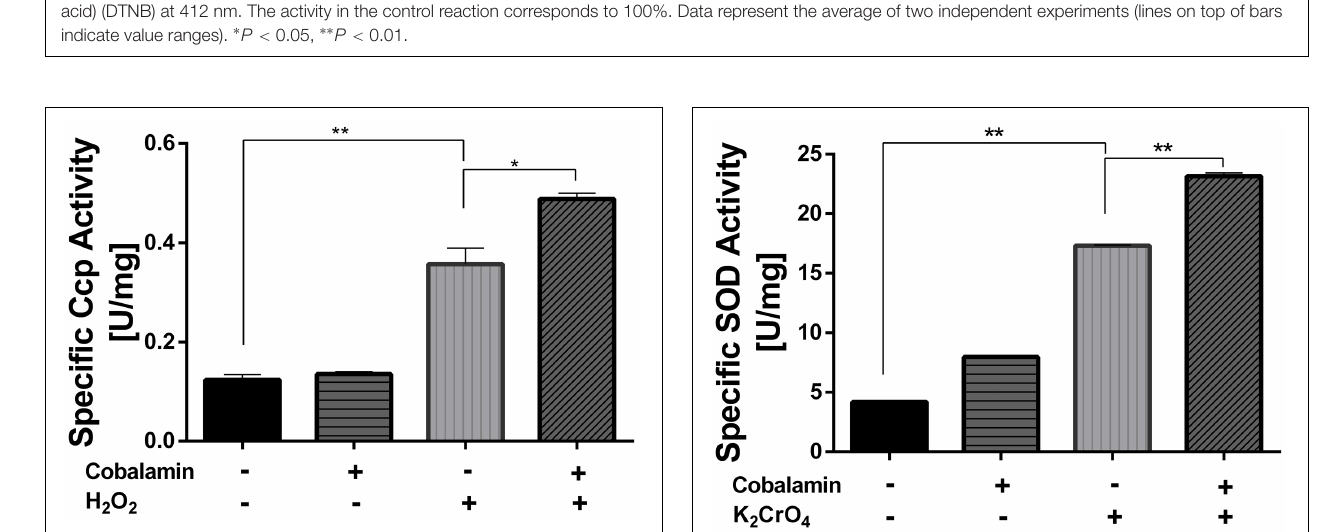
FIGURE 5 | Effect of cobalamin on superoxide dismutase activity. The activity was measured by following the inhibition of NBT-reduction at 560 nm as described under Section “Materials and Methods.” Data represent the average of two independent experiments (lines on top of bars indicate value ranges). One unit (U) is defined as the amount of enzyme necessary to decrease the reference rate to 50% of maximum inhibition. ∗∗ P <